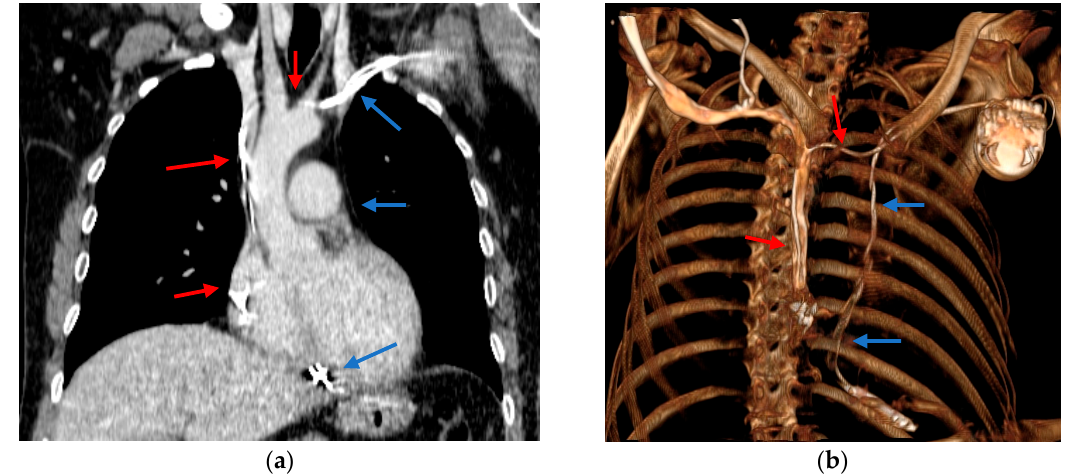
Figure 6. ( a ) Computed tomography angiography (venous phase) showing: the defibrillation lead going through the left SVC, the CS and, finally, into the RV (blue arrows); the atrial lead through the right SVC and into the RAA (red arrows); ( b ) 3D reconstruction of the CD system: defibrillation lead (blue arrows), atrial lead (red arrows;) Abbreviations: SVC—superior vena cava; CS—coronary sinus; RV—right ventricle; RAA—right atrial appendage; CD—cardioverter defibrillator.